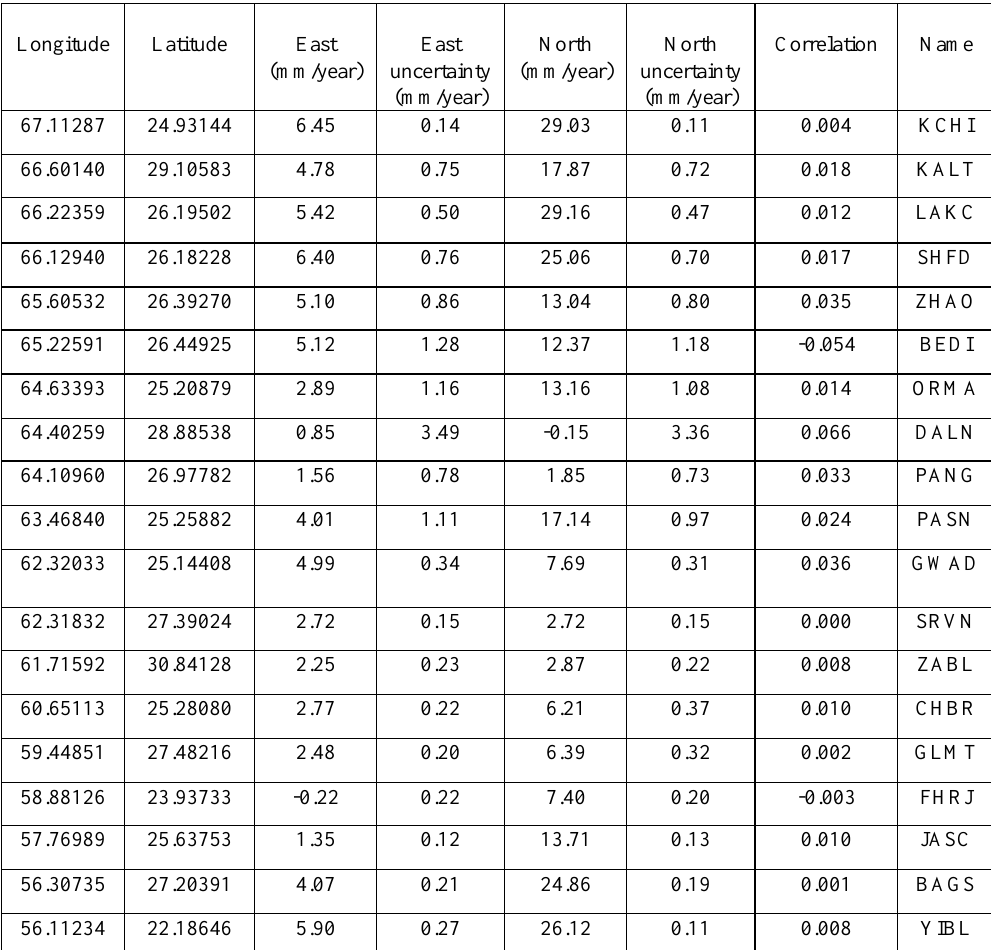
Table1. GPS velocities relative to the stable Eurasian plate as defined by Altamimi et al